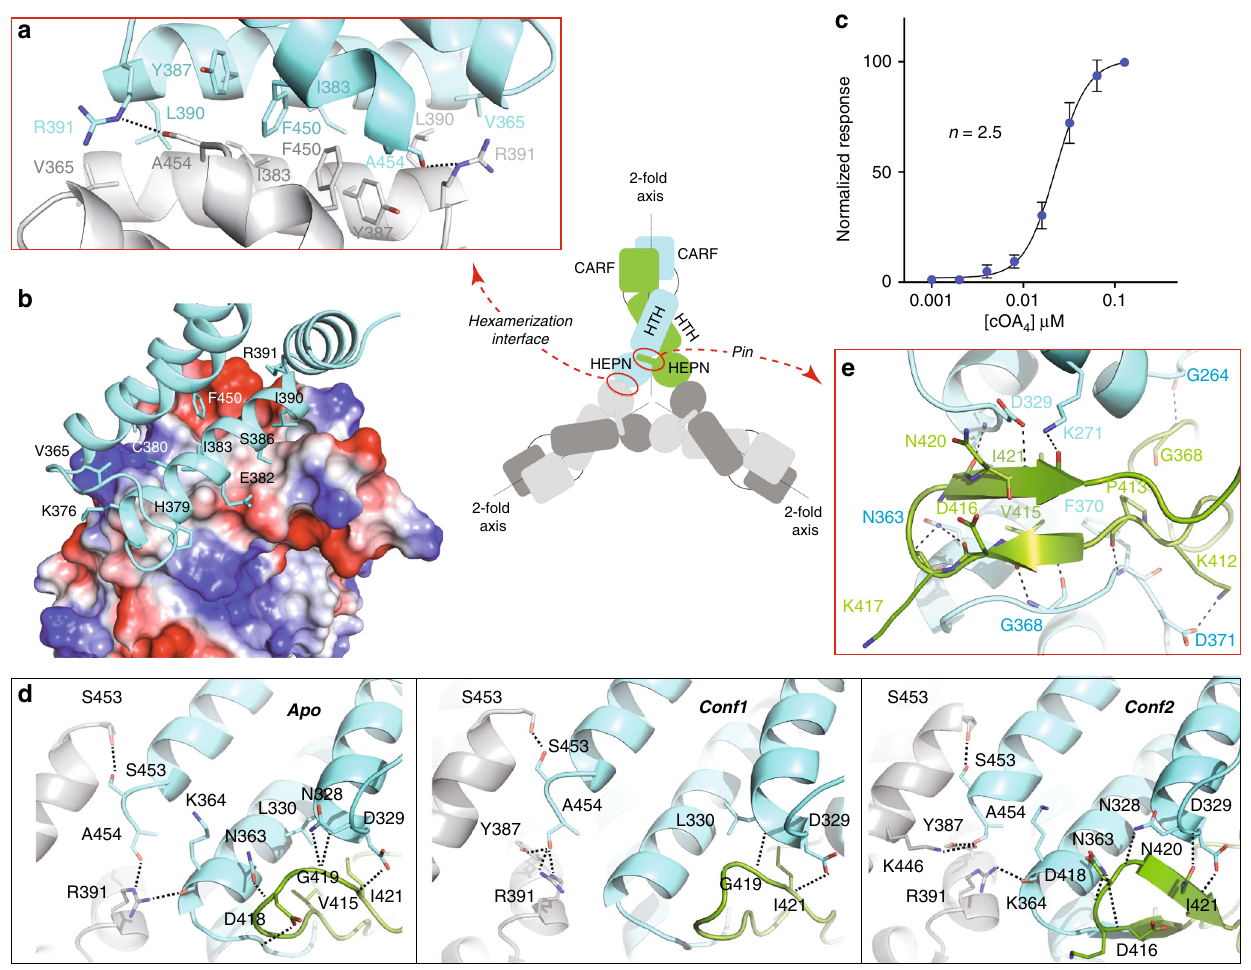
Fig. 5 Molecular basis of SisCsx1 cooperativity in ssRNA degradation. a Detailed view of the SisCsx1 helices building the hexamer interface. The sketch shows the domain organization of one of the SisCsx1 dimers in the hexameric arrangement. b Electrostatic potential of the interaction surface between the HEPN domains. c SisCsx1 RNase activity displays a cooperative behavior in the presence of increasing concentrations of cOA 4 . The experiment was repeated 3 times, the error bars represent the s.d. (Supplementary Fig. 8D). d Detailed view of the oligomerization interface in the apo, conf1 and conf2 structures showing the interplay of the hydrogen bond network between R391, Y387, K446, A453, and K364. e Detailed view of the pin of one of the HEPN domains (residues 405 – 427), which inserts in the neighbouring monomer. This feature is conserved in all the catalytic sites of the assembly forming a staggered arrangement (See also Supplementary movie